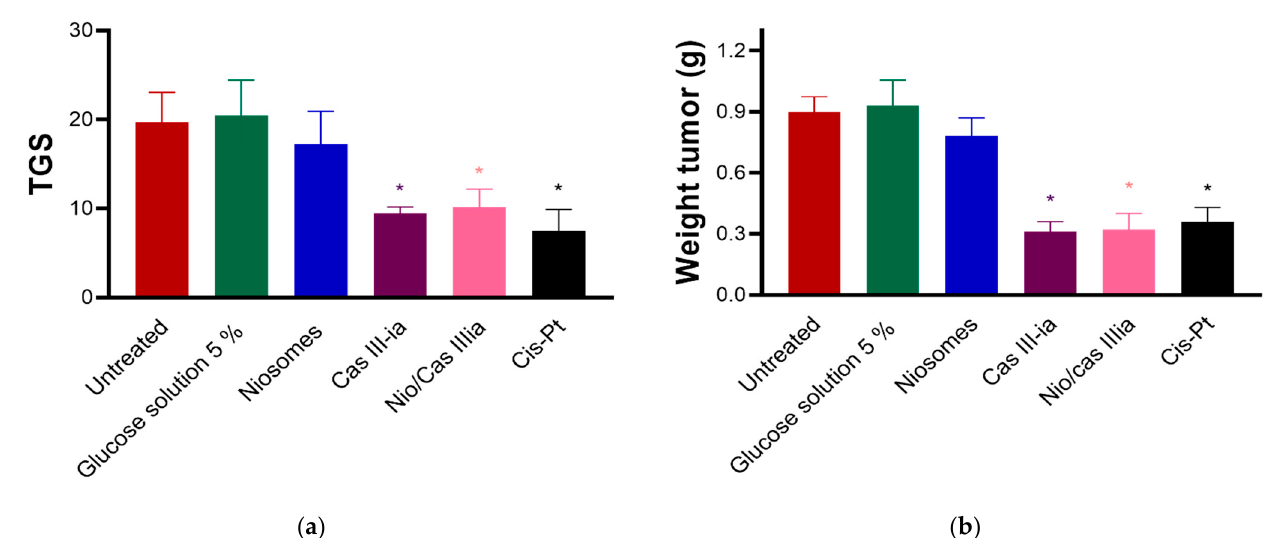
Figure 9. ( a ) Tumor growth speed (TGS) was calculated from tumor size based on the difference between day 21 and day 1. The unpaired t -test was used to evaluate statistically significant groups (marked with an asterisk). ( b ) Primary tumor weight for each treatment group. The unpaired t -test was used to evaluate statistically significant groups (marked with an asterisk).